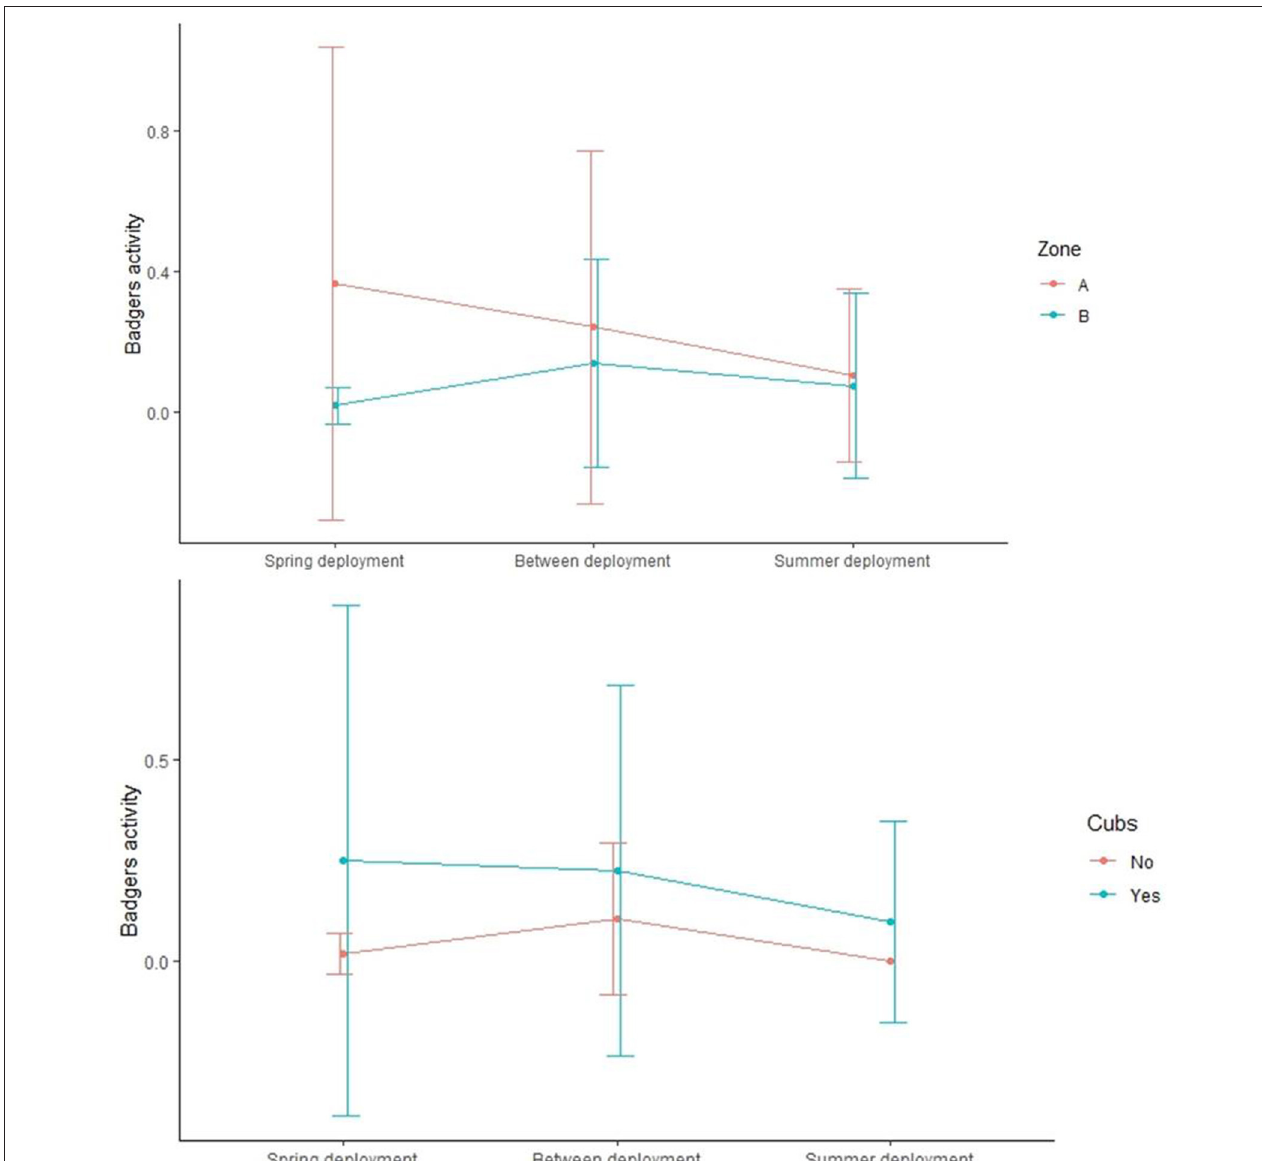
FIGURE 4 | Mean ( ± 95% CI) badger activity at social groups in zone A compared to zone B (top panel) and where cubs were detected or not by video surveillance (bottom